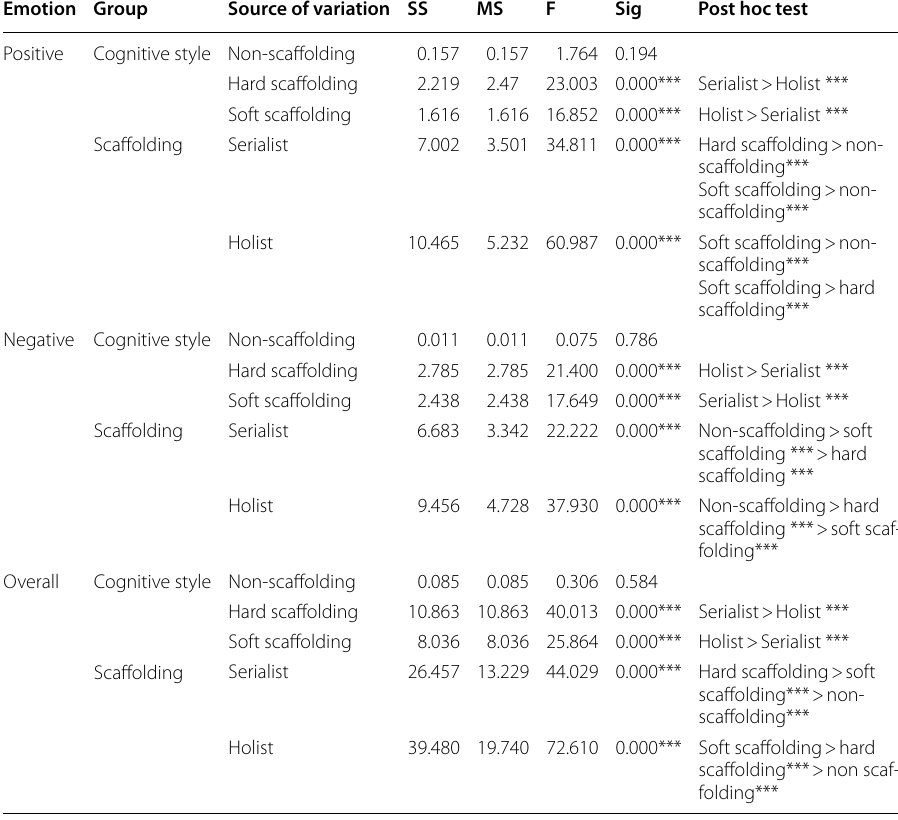
Table 4 Simple main effects of scaffolding DGBLs and cognitive styles on learning emotion